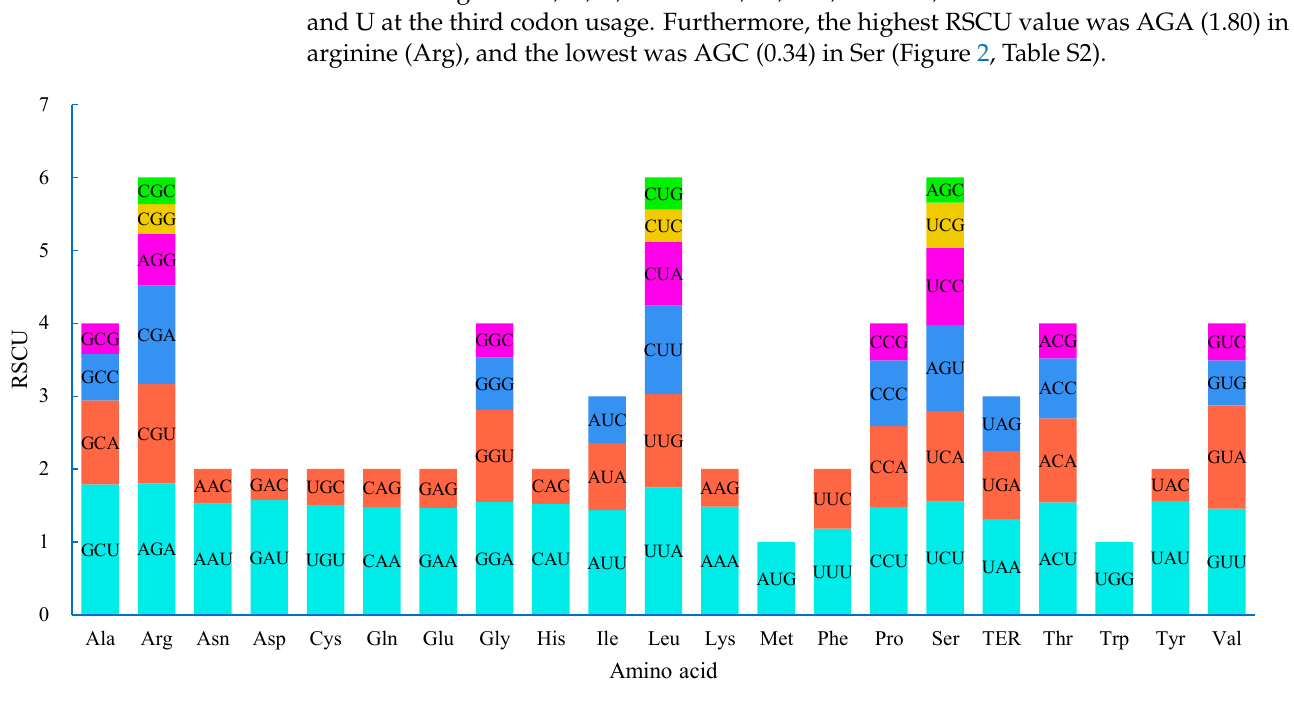
Figure 2. Codon usage patterns of D. grandiflora plastome. The y-axis represents the relative synonymous codon usage whereas x-axis represents the codons.